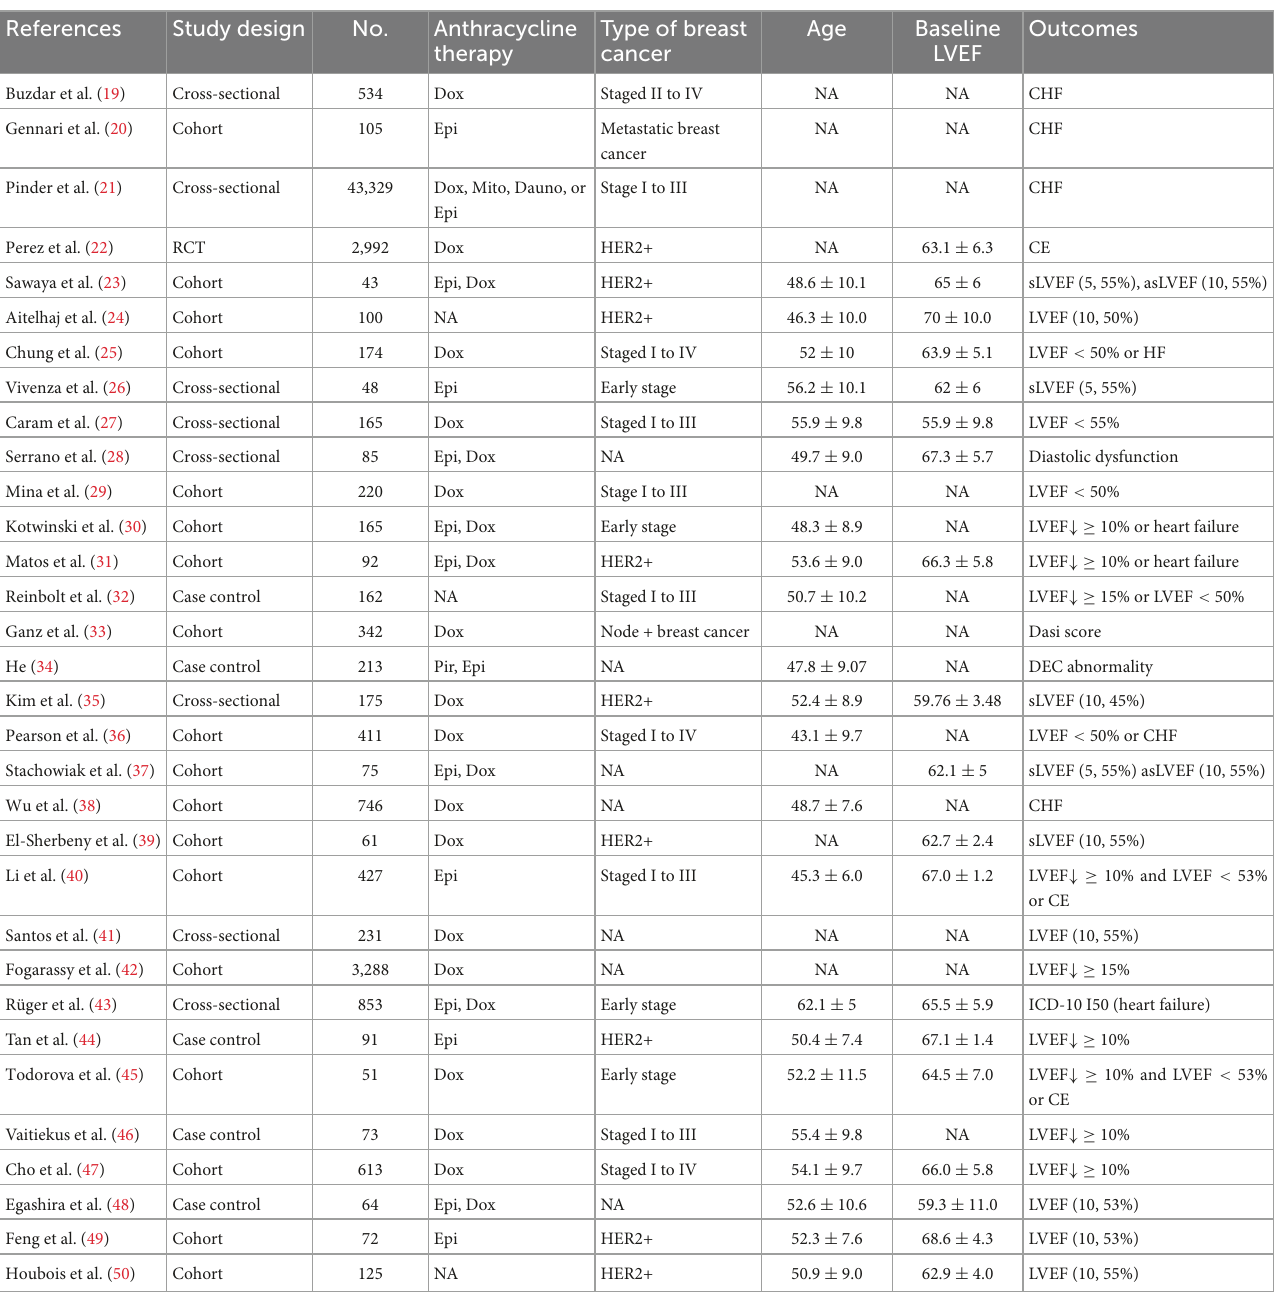
TABLE 4 Characteristics of the included